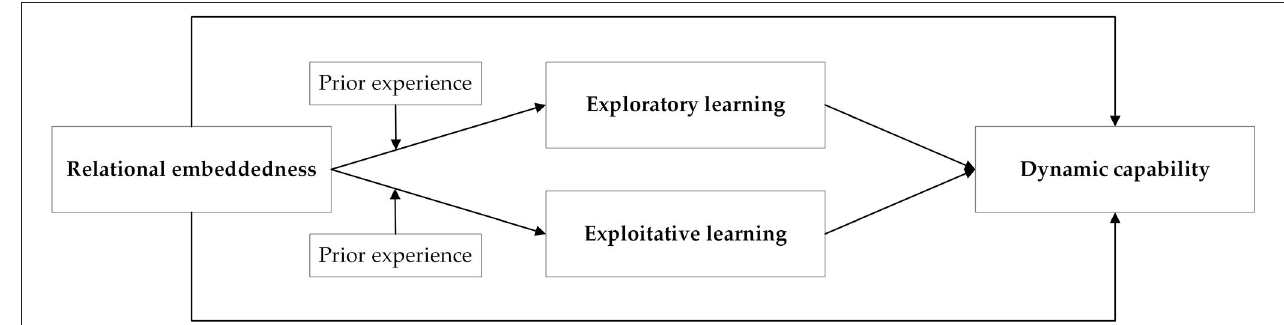
FIGURE 1 | Theoretical research